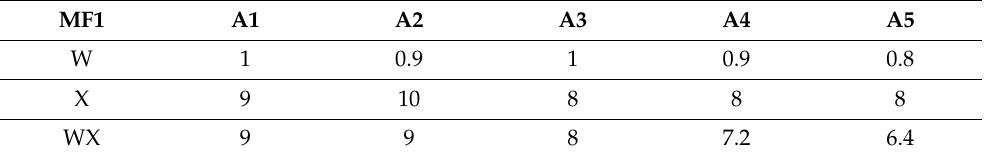
Table 5. MF1 evaluation by Organization A.